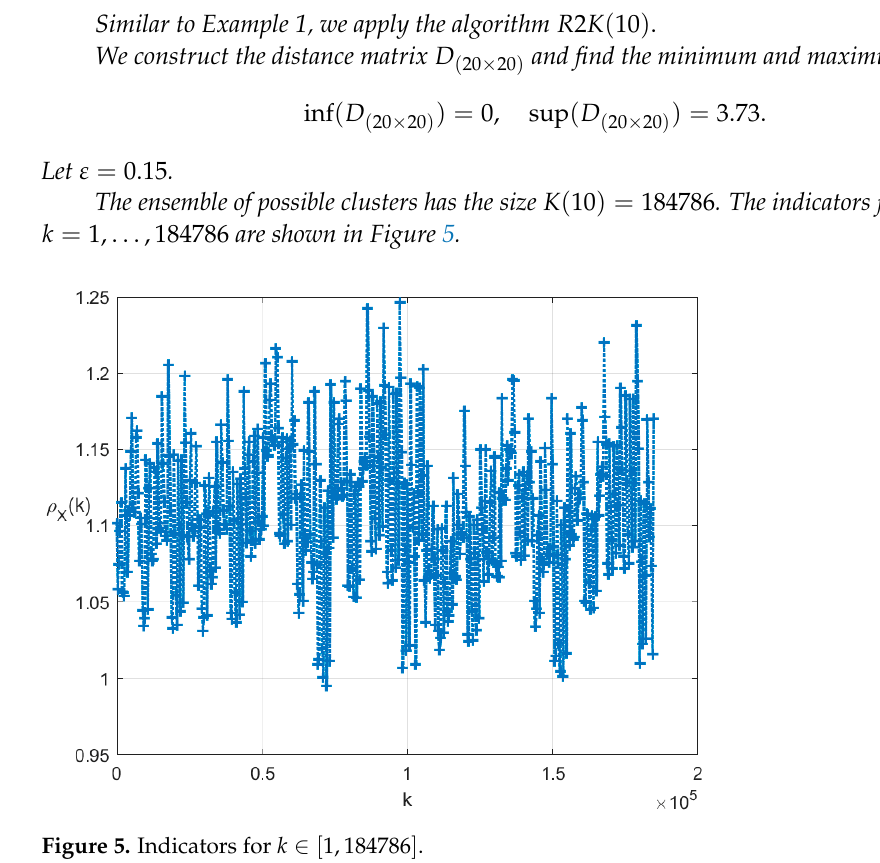
Figure 4. Data points on the two-dimensional plane.